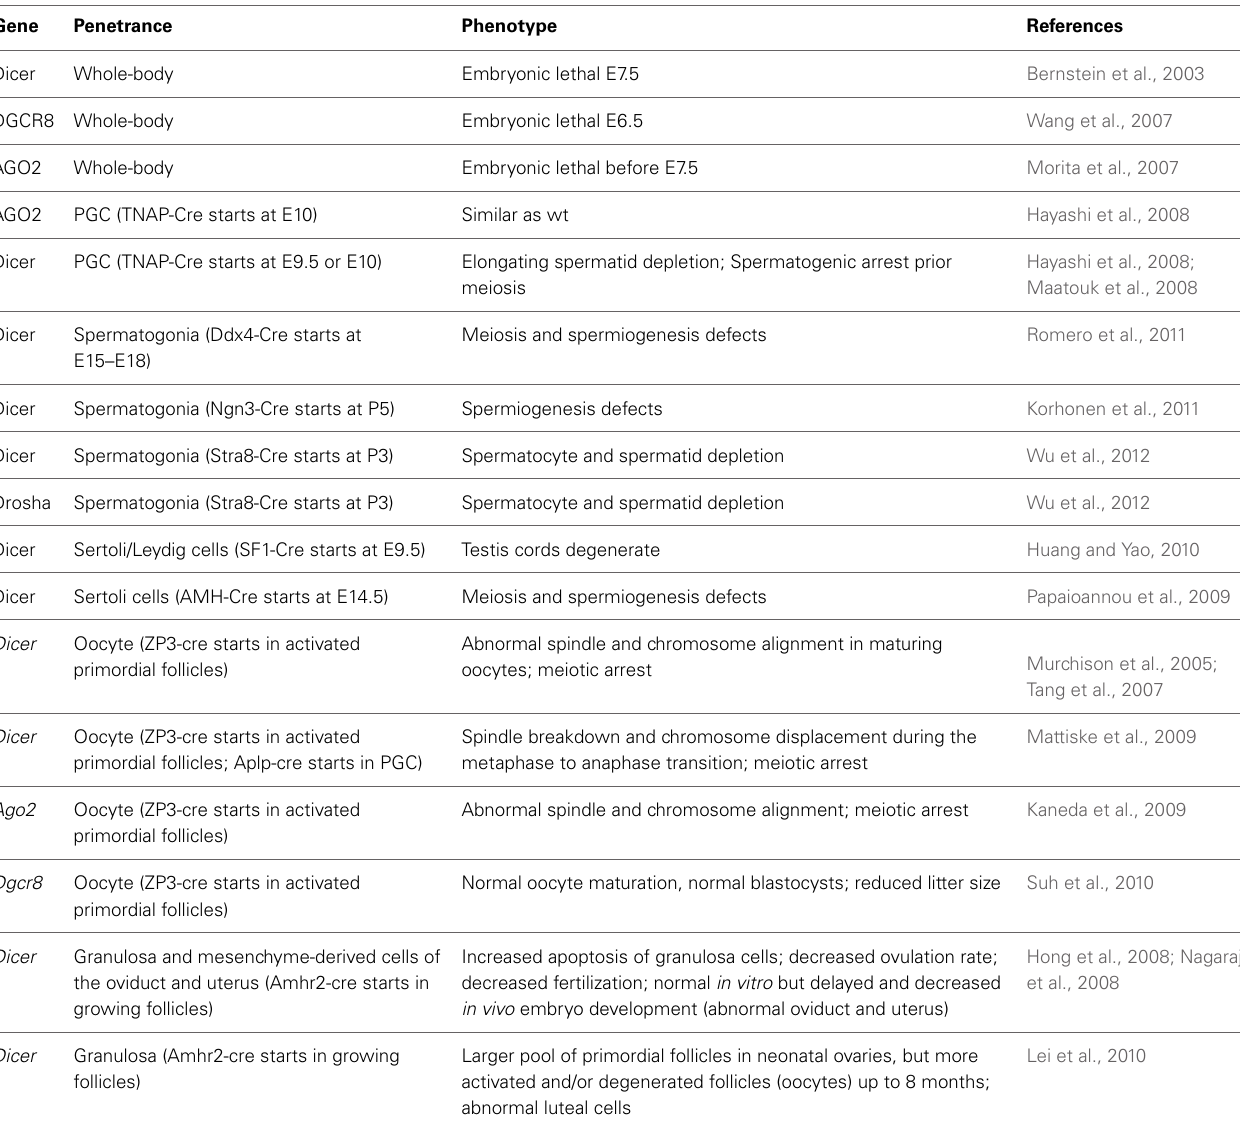
Table 1 | Phenotypic consequences of the depletion of genes involved in microRNA biogenesis in mouse.